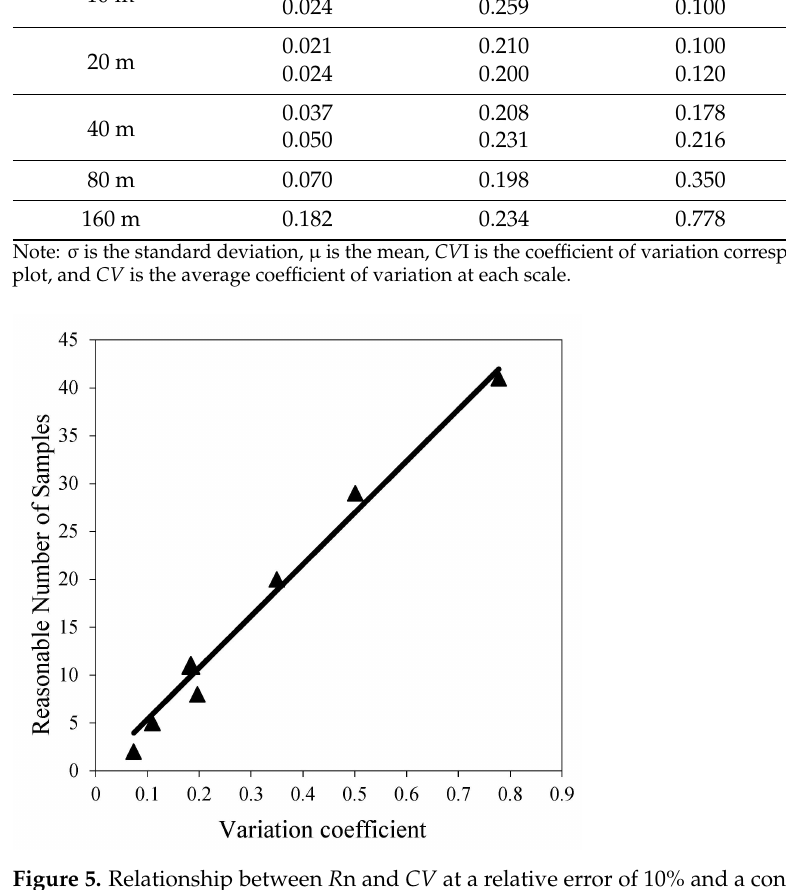
Figure 5. Relationship between R n and CV at a relative error of 10% and a confidence level of